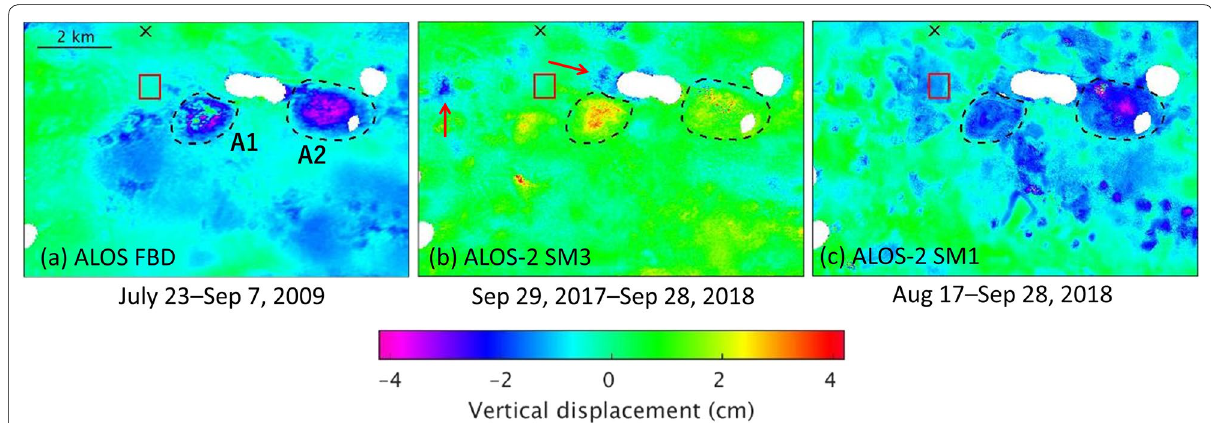
Fig. 3 Vertical displacement derived from unwrapped interferograms using a ALOS FBD, b ALOS-2 SM3, and c ALOS-2 SM1 data. The positive and negative values correspond to uplift and subsidence, respectively. White shows areas of no data due to low coherence and/or no data in AW3D. The ‘ x ’s indicate the reference points of the interferograms. The two areas marked A1 and A2 indicate the locations of the obvious signals (the legends are also used hereafter). The red arrows in ( b ) also show the obvious signals excluding those in ( a